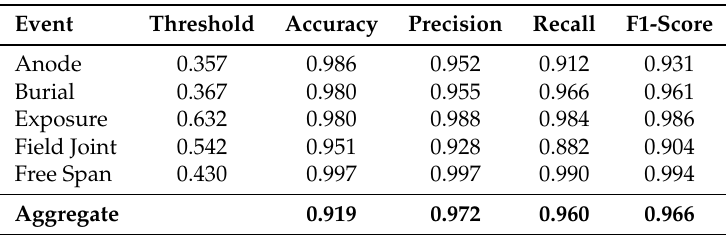
Table 4. Test set performance of individual labels and aggregate.